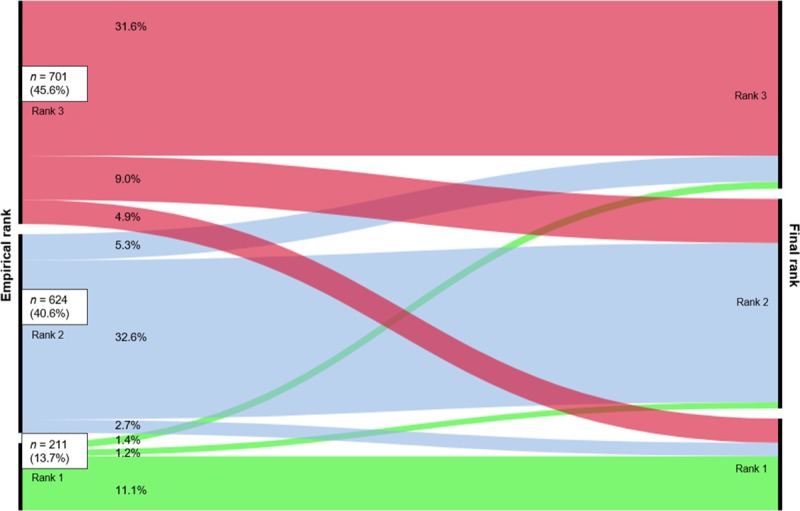
Alluvial-diagram of adjustment of empirical therapy.Rank-1 = narrow-spectrum- antibiotics, rank-2 = broad-spectrum-antibiotics, rank-3 = extended-spectrum-antibiotics. Continued regimen is a straight line, de-escalation is a falling line, escalation is a rising line.